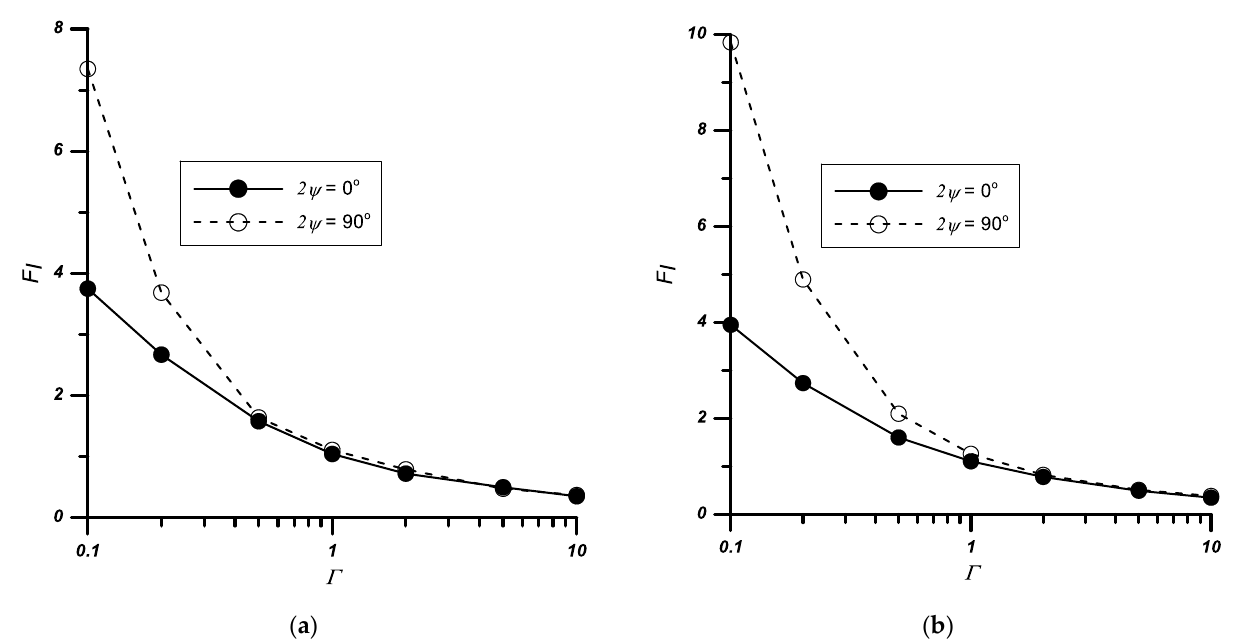
Figure 10. Variation of the normalised stress intensity factors F I with the relative stiffness Γ and the notch angle 2 ψ , ( a ) for σ x / σ y 1 = 1, ( b ) for σ x / σ y 1 = 0.5, a/w = 0.4.